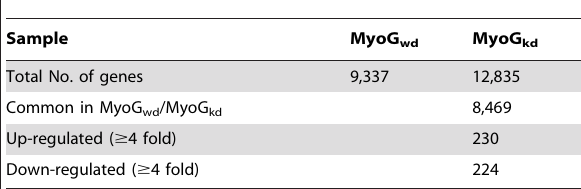
Table 2. Gene expression